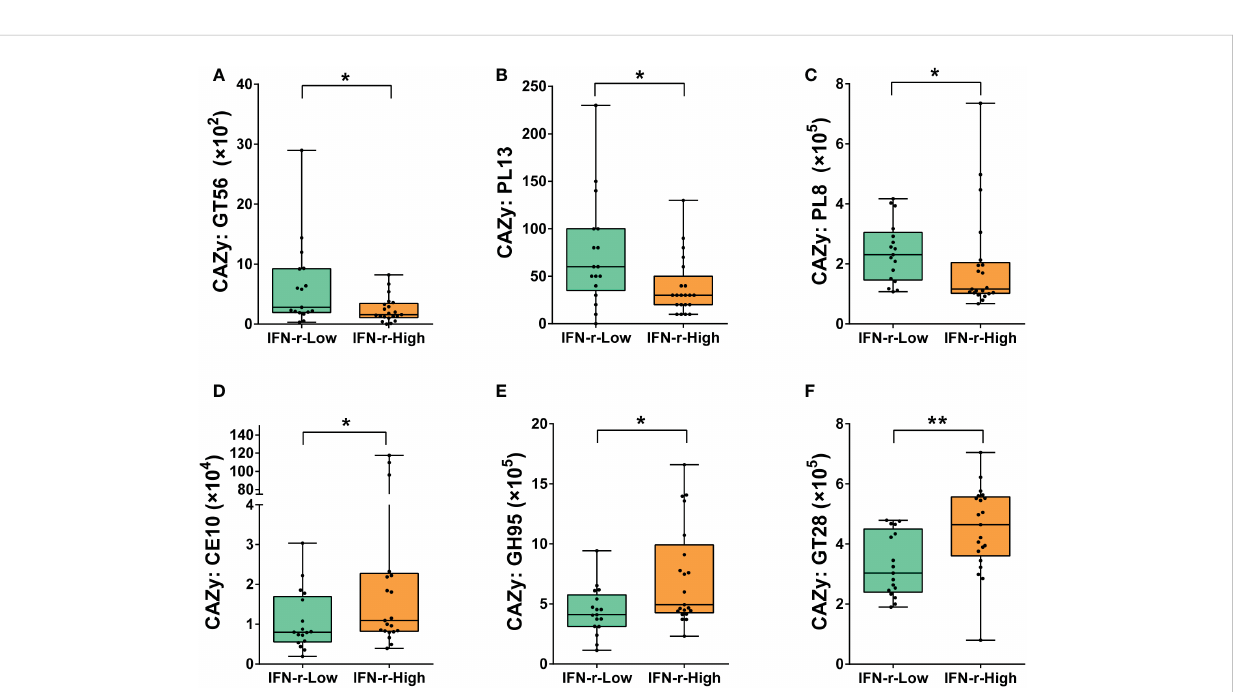
FIGURE 5 Differences of the abundances of genes encoding carbohydrate-active enzymes (CAZymes) in the fecal microbiome between the IFN- g -Low and IFN- g -High groups. The values of the points represent the relative abundances of genes encoding (A) GlycosylTransferase Family 56 (GT56), (B) Polysaccharide Lyase Family 13 (PL13) and (C) Polysaccharide Lyase Family 8 (PL8), (D) Carbohydrate Esterase Family 10 (CE10), (E) Glycoside Hydrolase Family 95 (GH95) and (F) GlycosylTransferase Family 28 (GT28). The horizontal line and the box indicate the median and the interquartile range (IQR), and the whisker spans the minimum to maximum. * p <0.05, ** p <0.01.